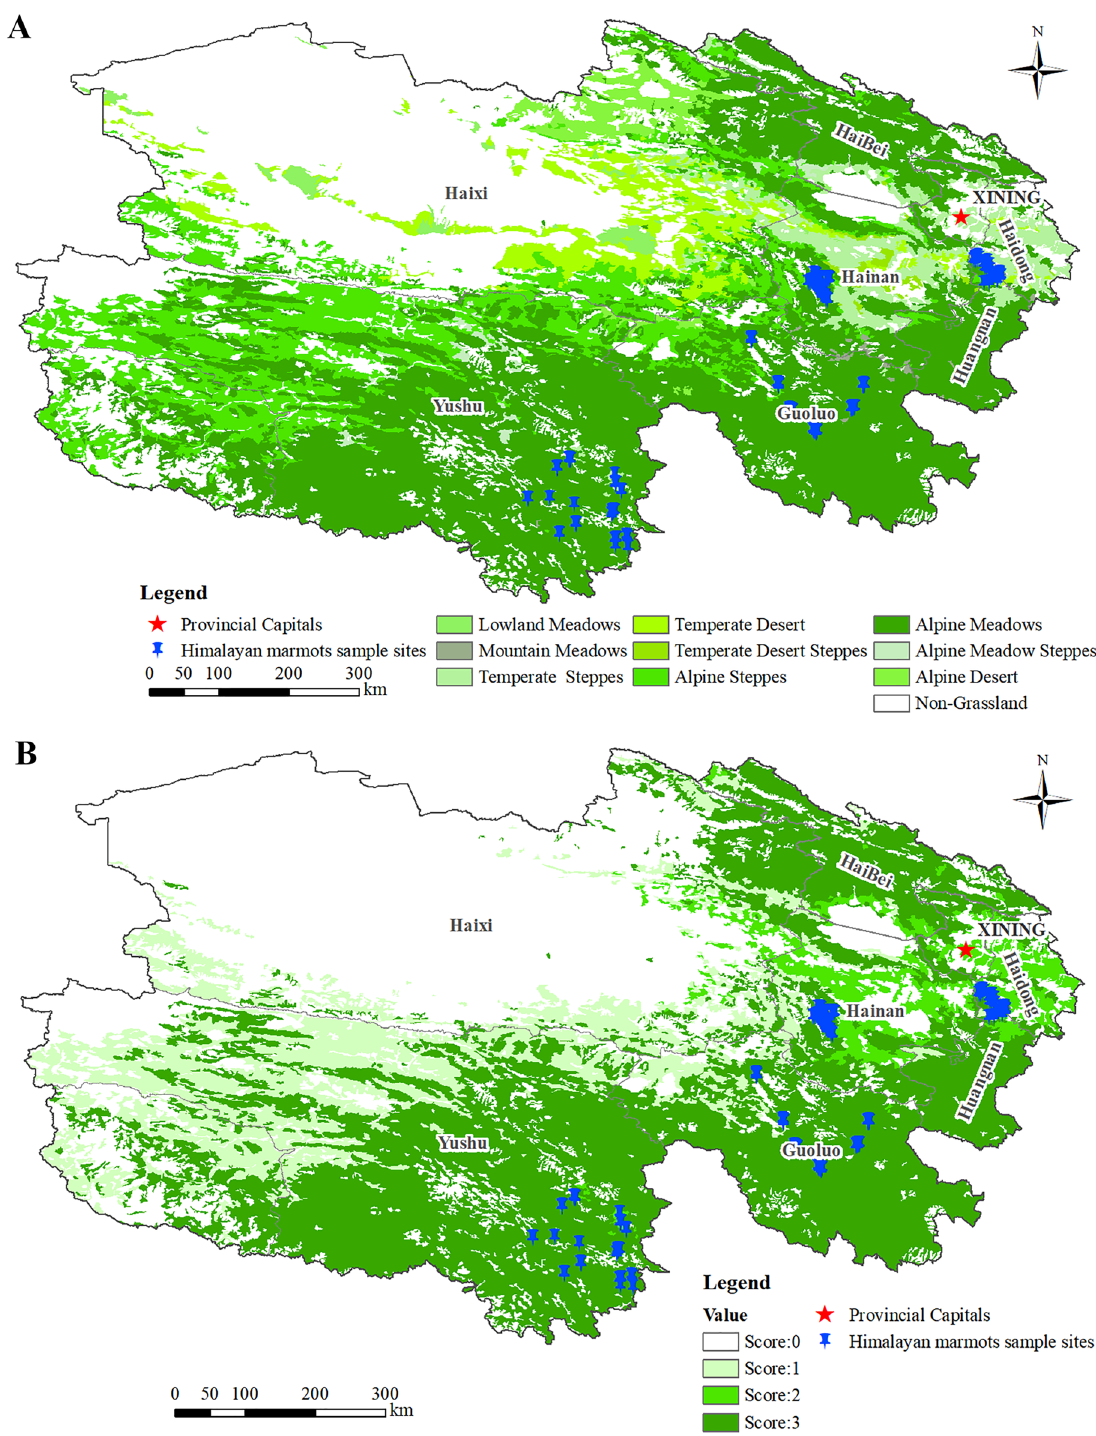
Figure 4. Province-wide grassland types ( A ); Reclassification of grassland types ( B